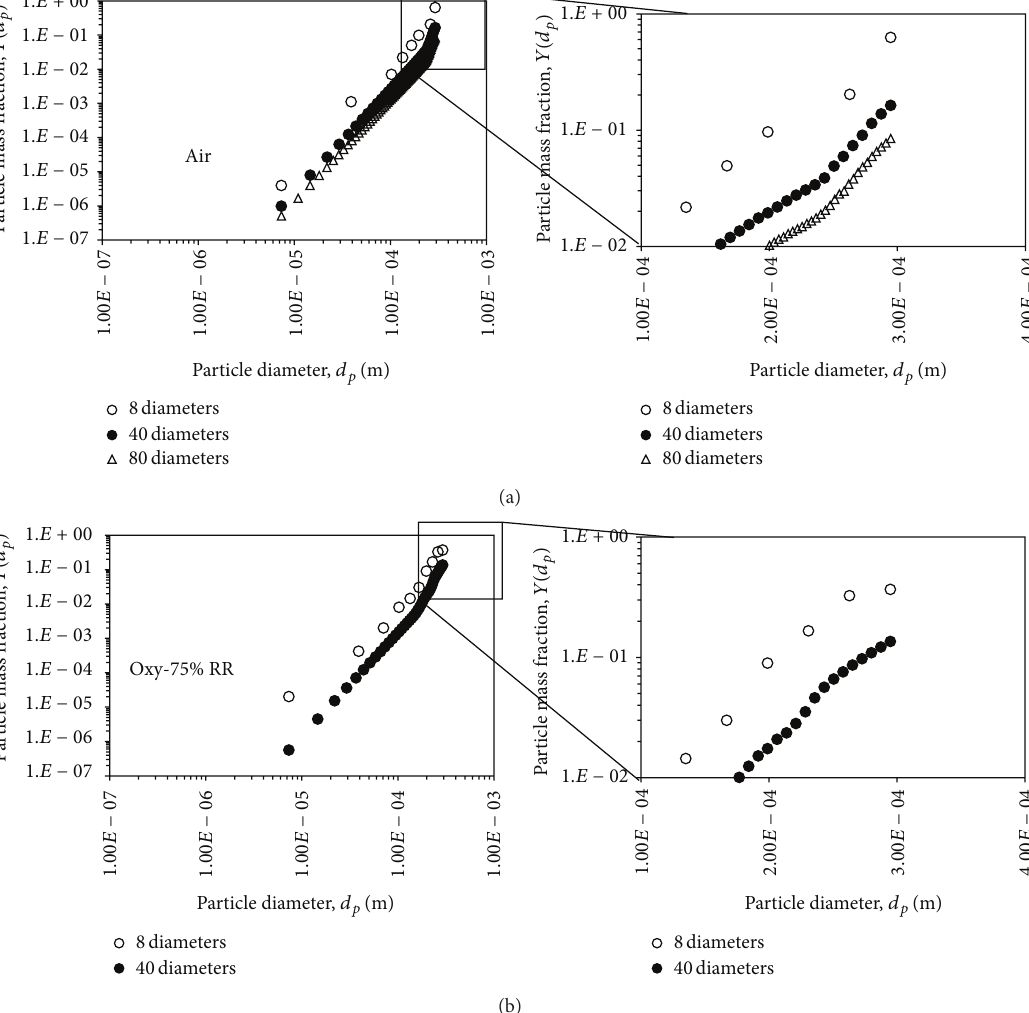
Figure 13: Sensitivities of the mass fraction distribution to different particle sizes as a function of the number of diameter intervals (or resolution in the R-R distribution) during combustion of Russian